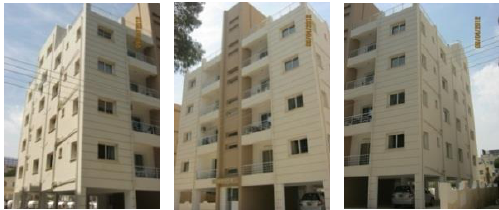
Figure 3. From right to left. North, South and East facade of Figure 4. From left to right. West, North, South façade of the